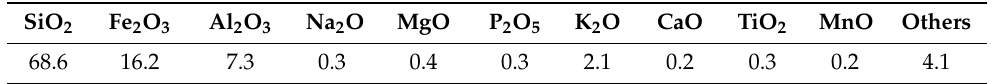
Table 1. Chemical composition of weathered residual rare earth ore, as analyzed by X-ray fluorescence (mass %) [2].